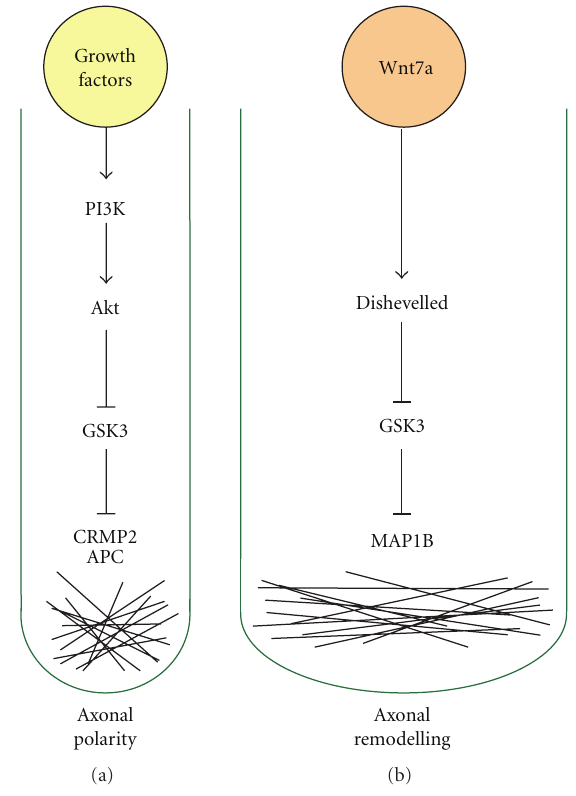
Figure 1: GSK3 roles, substrates and signalling in immature nerve terminals. (a) Inhibition of GSK3 activity is essential for the establishment of axonal polarity. GSK3 activity is inhibited by growth factors that signal through the PI3K/Akt signal transduction cascade. When GSK3 is active, it phosphorylates both CRMP- 2 and APC, which prevents their interaction with microtubules, arresting microtubule polymerization. When GSK3 is inhibited by growth factors, it cannot phosphorylate CRMP-2 or APC; therefore microtubule polymerization is stimulated. (b) Axonal remodelling describes decreased axonal growth, increased axon diameter, and increased growth cone size when a nascent axon meets a postsy- naptic target. Inhibition of GSK3 increases microtubule stability to allow axonal remodelling. GSK3 activity is inhibited by a divergent Wnt signalling cascade. When GSK3 is active, it phosphorylates MAP-1B; which results in increased microtubule instability. When GSK3 is inhibited by Wnts, it cannot phosphorylate MAP-1B therefore microtubules are